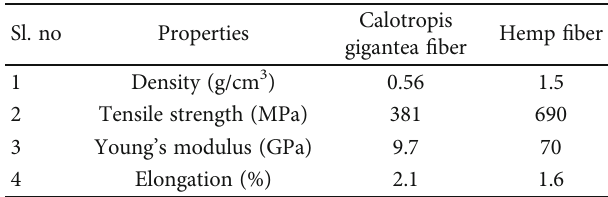
Figure 2: Extraction of hemp fi ber from hemp plant. Table 1: Mechanical properties of reinforcements used in the current